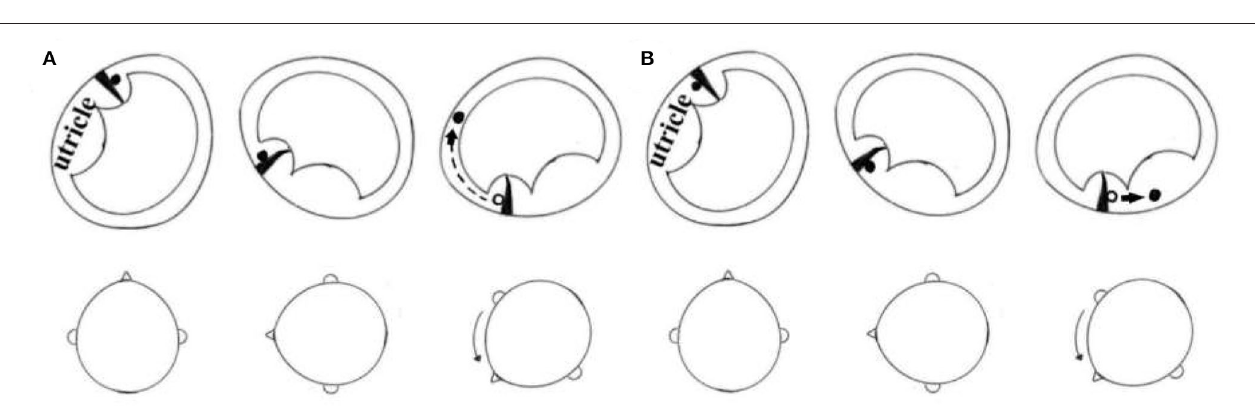
FIGURE 2 | New application of the Gufoni nose-down variation. (A) Debris on the canal side. (B) Debris on the utricular side. The right side is the affected side in both cases.